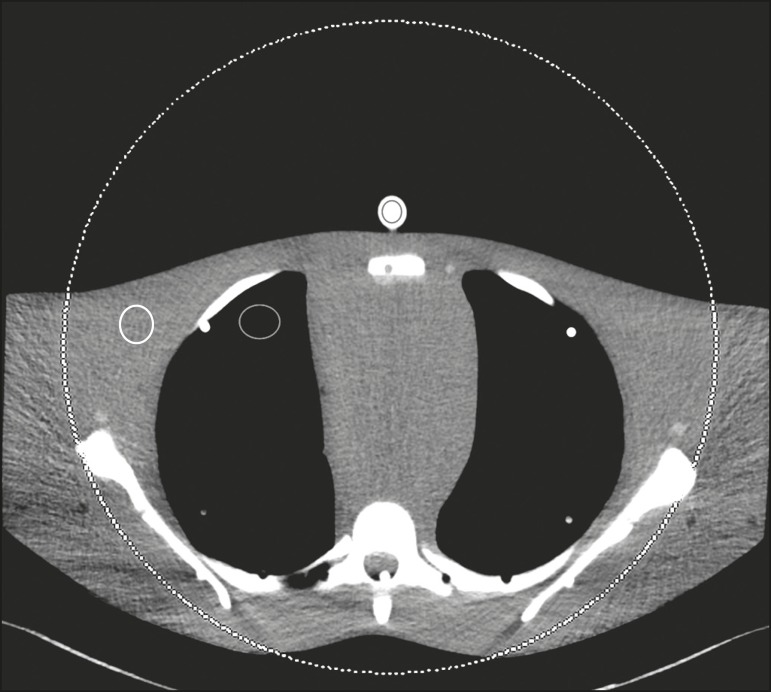
Transverse CT image of the anthropomorphic thoracic phantom. ROIs
were drawn to measure HU at three different locations (soft tissues,
right upper lung, and the test tubes filled with diluted contrast
medium).